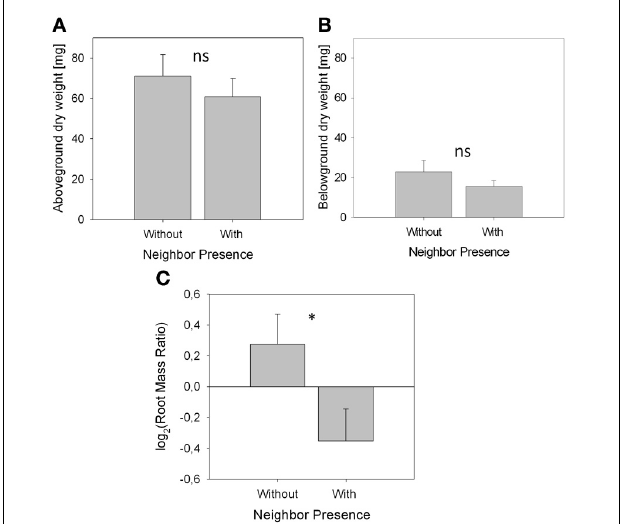
FIGURE 2 | Biomass parameters and root distribution (means ± SE) of A. thaliana without neighbor (control, n = 11) and with neighbor present ( n = 9). Asterisks denote statistically significant differences in t -tests with ∗ p < 0 . 05; ns, not significant. (A) , Above-groundbiomass. (B) , Belowground biomass. (C) . Root distribution pattern represented by log 2 (RR) based on root dry